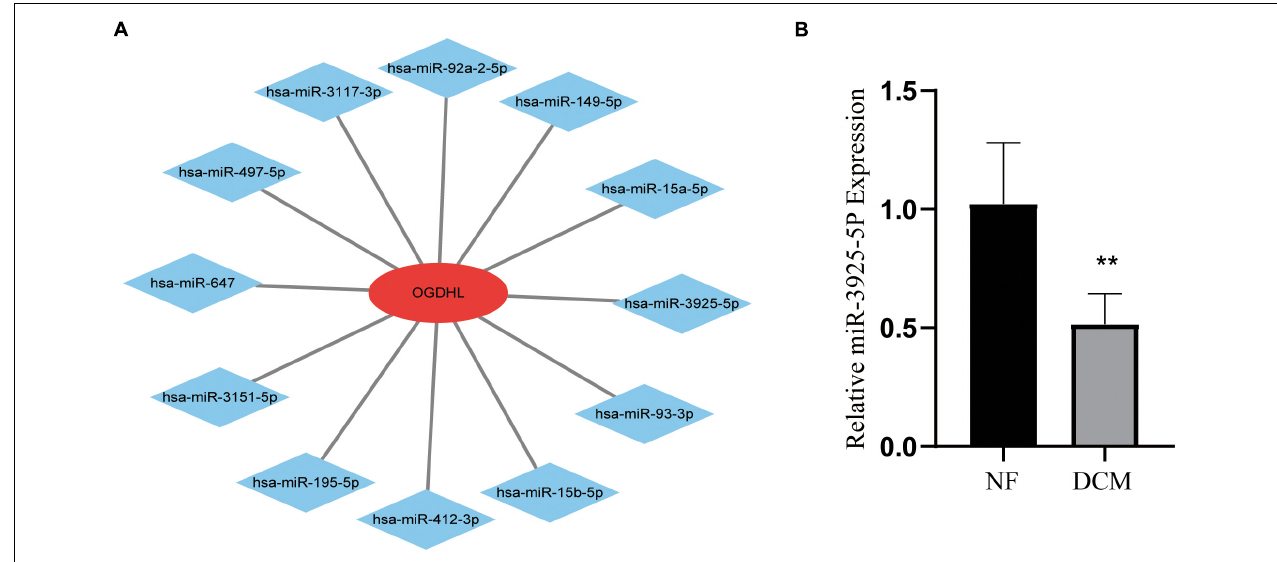
FIGURE 7 | Identification of candidate OGDHL-targeting miRNA. (A) The predicted 12 candidate OGDHL-targeting miRNAs. (B) The expression level of miR-3925-5p in left ventricular tissues of patients with DCM and NF donors. ** P < 0.01 vs. NF. n =